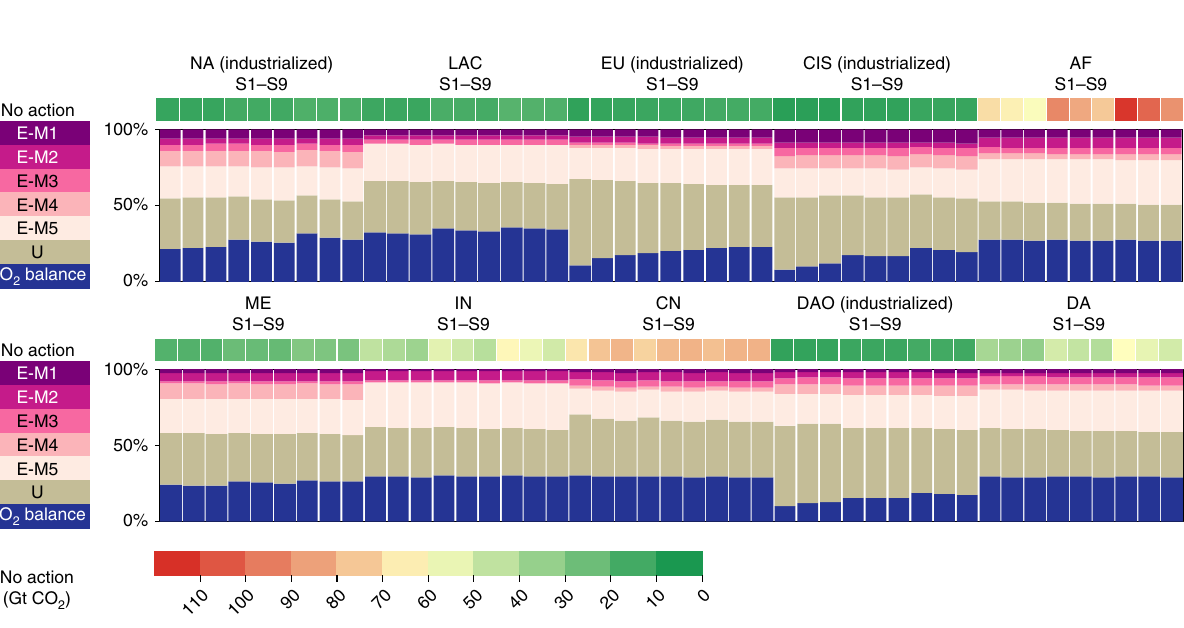
Fig. 3 Regional patterns of cumulative non-action CO 2 emissions (2015 – 2100) and relative contribution of the fi ve supply-side CO 2 emissions mitigation measures, CO 2 uptake, and CO 2 balance. The fi ve supply-side measures refer to those listed in Table 1. The red-yellow-green palette represents the 2015 – 2100 cumulative (no-action) CO 2 emissions. The column chart represents the relative contribution of the fi ve supply-side CO 2 emissions mitigation measures, CO 2 uptake, and the remaining CO 2 balance. NA North America, LAC Latin America & Caribbean, EU Europe, CIS Commonwealth of Independent States, AF Africa, ME Middle East, IN India, CN China, DAO Developed Asia & Oceania, DA Developing Asia. S1: low –